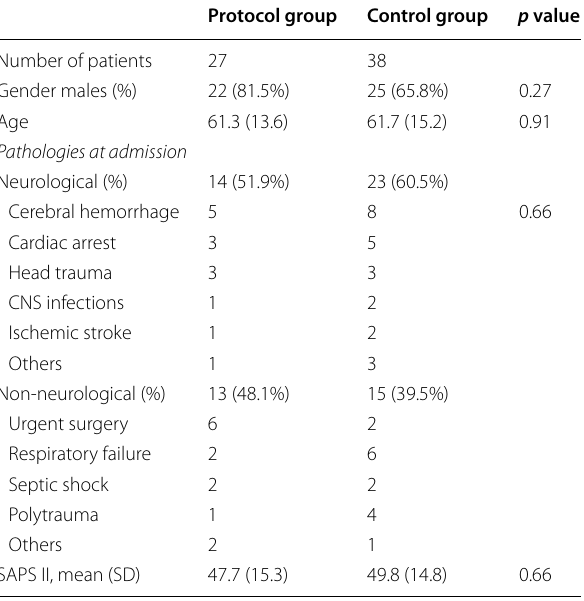
Table 1 Characteristics of the study